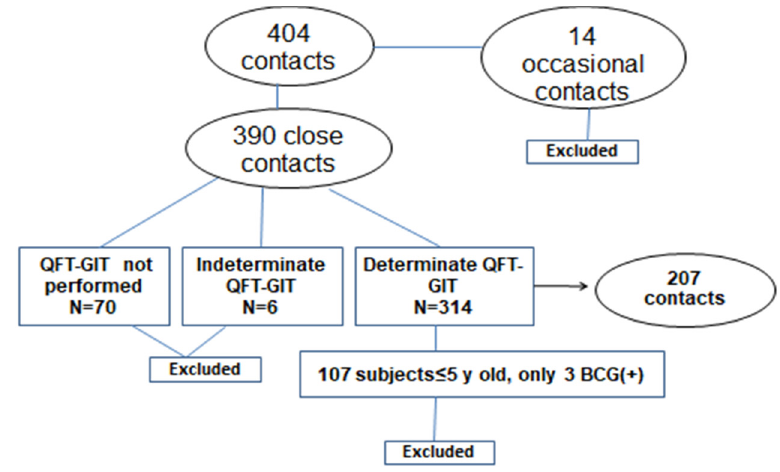
Figure 1. Flow diagram with patients enrolled in the